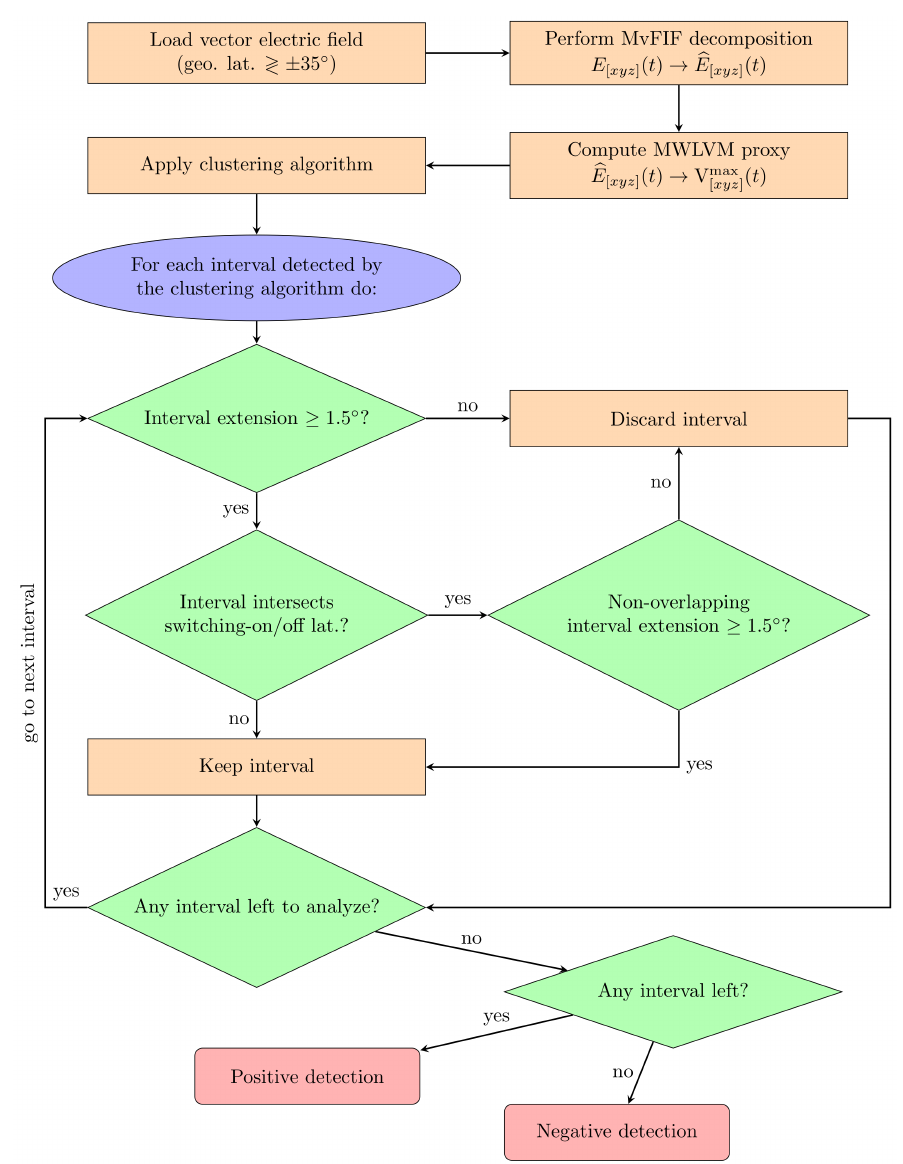
Figure 6. Flowchart describing the AOD